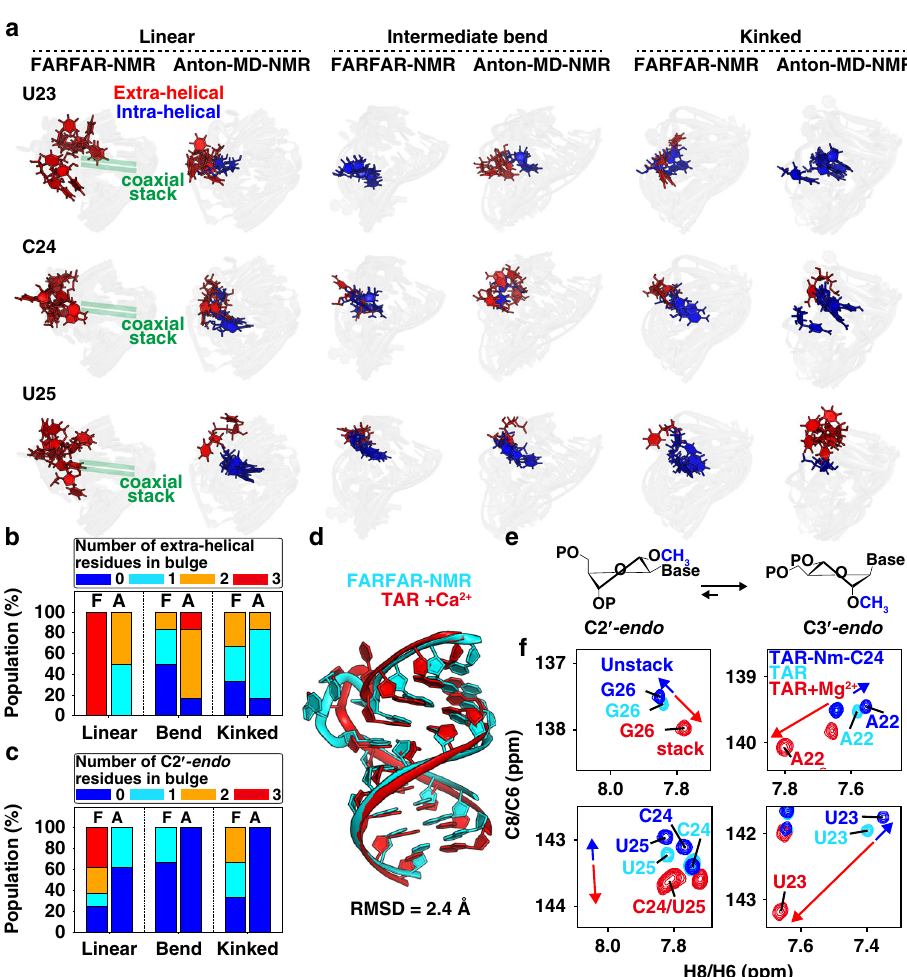
Fig. 5 Cooperative extra-helical fl ipping and sugar repuckering of bulge residues are coupled to coaxial stacking. a Overlay of conformers showing motions in bulge residues for linear (| β h | < 45°), intermediate bend (45° < | β h | < 70°) and kinked (| β h | > 70°) inter-helical conformations in the FARFAR- NMR and Anton-MD-NMR ensembles. b , c The fractional populations of conformers with the number of b extra-helical and c C2 ′ - endo residues (color- coded) in the bulge residues (U23, C24, and U25) as a function of bending angle in the FARFAR-NMR ( “ F ” ) and Anton-MD-NMR ( “ A ” ) ensembles ( N = 20). d Comparison of one coaxially stacked FARFAR-NMR conformer with the crystal structure of Ca 2 + -bound TAR (PDBID: 397D) 33 . e Nm shifts sugar- pucker equilibrium towards C3 ′ - endo . f Overlay of 2D [ 13 C, 1 H] HSQC NMR spectra of the aromatic spins for TAR-Nm-C24 without Mg 2 + (blue) with blue arrows indicate unstacking, TAR without Mg 2 + (cyan) and TAR with 3 mM Mg 2 + (red) with red arrows indicating increased coaxial